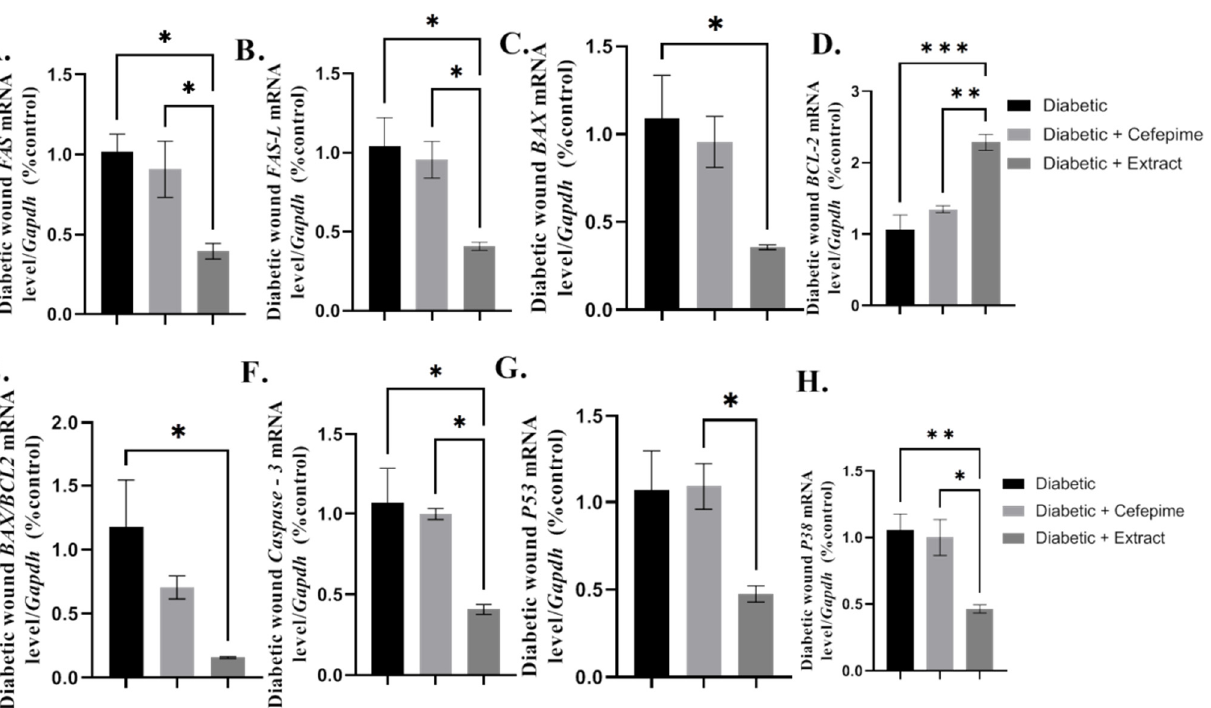
Figure 8. Effect of the hydrogel topical application of cefepime and CEF once daily for 14 successive days on the mean fold change of the mRNA relative expression of the apoptosis signaling pathway ( FAS , FAS-L , BAX , BCL-2 , BAX/BCL-2 , Caspase-3 , P53 , and P38 ) to internal control gene Gapdh ( A – D ) and collagen deposition ( E , F ) of diabetic wound infected with clinical isolates of P. Mirabilis infected LC587231 in type 1 diabetic rats. ( A ): mRNA relative expression of FAS to internal control gene Gapdh , ( B ): mRNA relative expression of FAS-L to internal control gene Gapdh , ( C ): mRNA relative expression of BAX to internal control gene Gapdh , ( D ): mRNA relative expression of BCL-2 to internal control gene Gapdh , ( E ): mRNA relative expression of BAX/BCL-2 to internal control gene Gapdh , ( F ): mRNA relative expression of Caspase-3 to internal control gene Gapdh , ( G ): mRNA relative expression of P53 to internal control gene Gapdh, and ( H ): mRNA relative expression of P38 to internal control gene Gapdh . *** Distinctive difference; ** Moderate difference; * Scant difference.